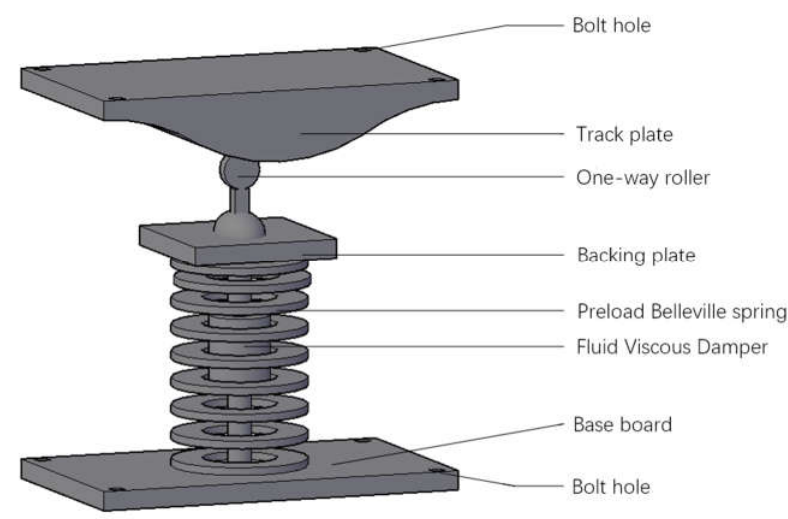
Figure 1. Schematic diagram of damping-track-type variable-stiffness device.